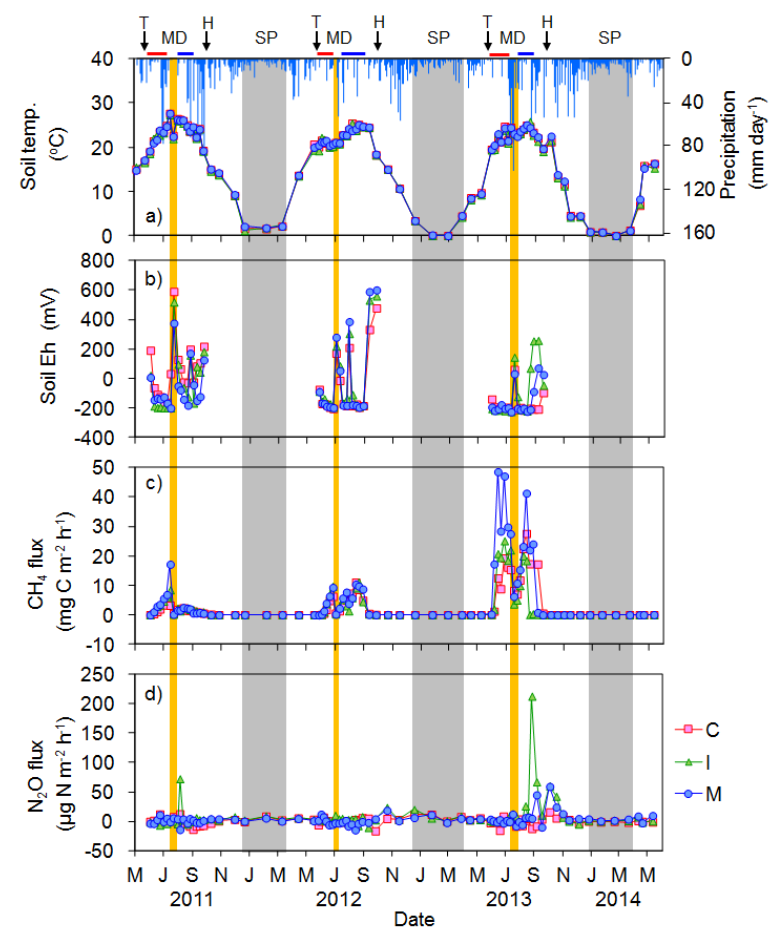
Figure 3. Seasonal changes in: ( a ) soil temperature and precipitation (bars); ( b ) soil Eh; as well as ( c ) methane (CH 4 ) and ( d ) nitrous oxide (N 2 O) fluxes during the rice cultivation period (paddy). Positive flux values indicate emission to the atmosphere and negative indicate uptake from the atmosphere. In the late August 2013, accidental drainage with drainage system trouble occurred in the immature compost plot. C: control; H: harvesting; I: immature compost; M: mature compost; MD: Mid-season drainage (orange area); SP: snow period (gray area). Red lines before MD and blue lines after MD indicate continuous flooding and intermittent drainage,